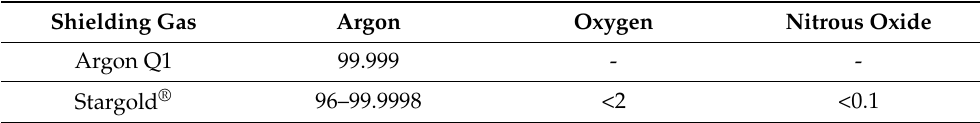
Table 2. Shielding gases composition percentage (%) [20].